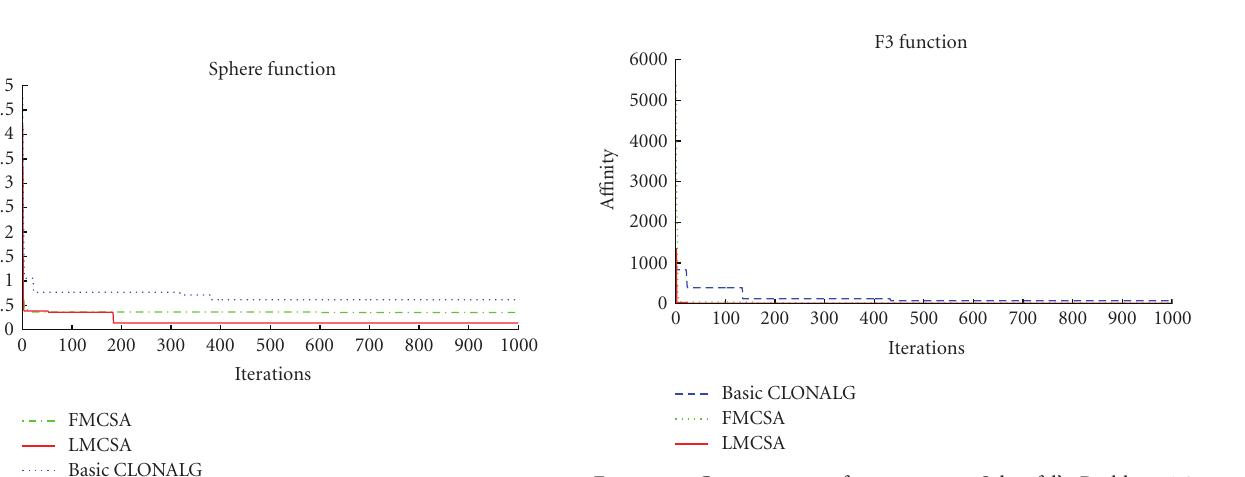
Figure 5: Convergent performances on Schwefel’s Problem 1.2 function ( f